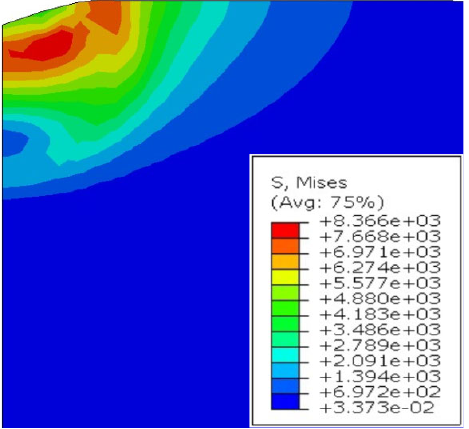
Figure 5. Response comparison of the established FE model and the published result [36].